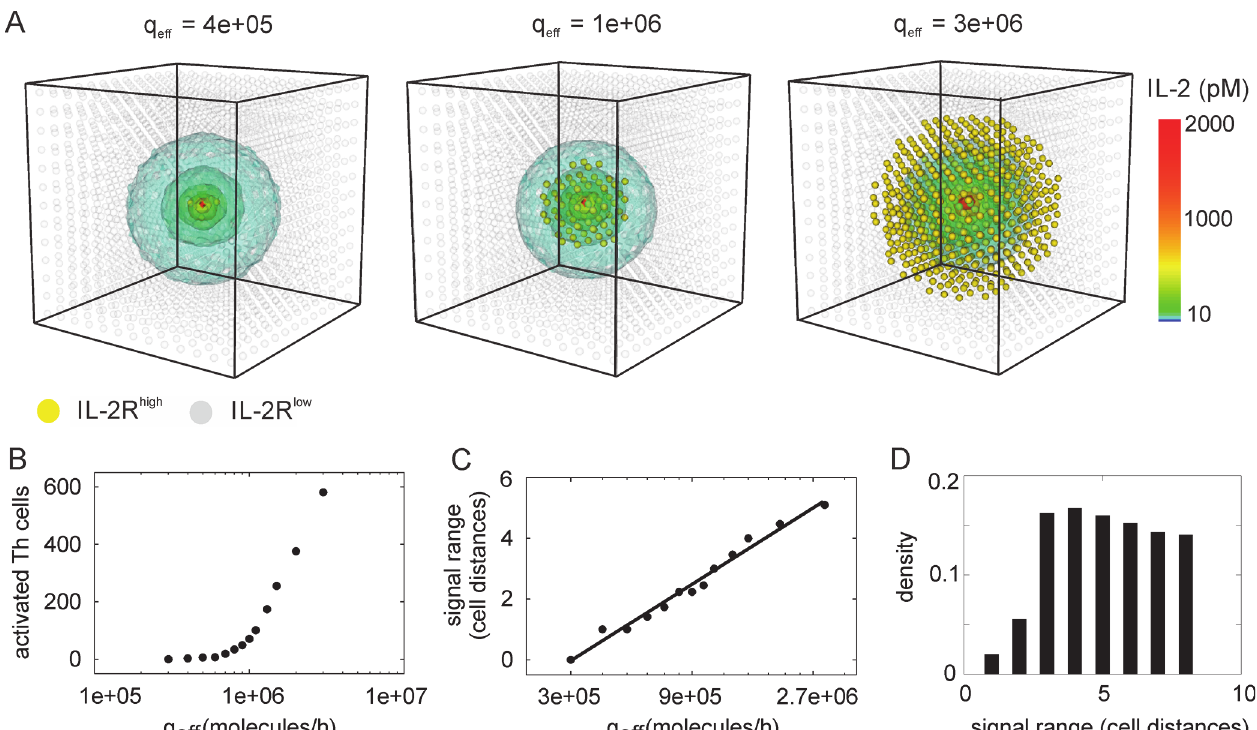
Fig 5. Spatial range of paracrine IL-2 signals. (A) Large-scale simulation (2198 Th cells) with one IL-2 secreting Th cell placed in the center, q eff = 10 6 molecules/h. 71 Th cells are activated (IL-2R high , marked gold). (B) Activated Th cells in simulations as shown in A, for varying values of q eff . (C) Spatial range of the effective paracrine signal. Dots are replotted from panel B, with the signal range determined given in cell distances, i.e. by the distance from the center of the region to the most distant activated cell, normalized by the distance between the centers of two cells (15 μ m). The solid line is a best fit to the function f ( x ) = a ln( x / x 0 ) (D) Distribution of traveling distances of cytokine molecules. The traveling distance is the distance from the secreting cell at which ligands are bound by receptors. These distances are obtained from a pulsed, homogeneous secretion simulation in a domain of 4913 responding cells (17 in each direction in 3D; see Methods). The traveling distance is shown as signal range, calculated as in (C).